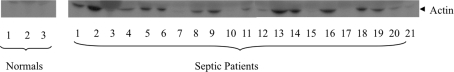
Actinemia occurs in human sepsis.Western Blot (WB) of plasma from septic patients and normals staining for actin shows that actin is present in the plasma of 17/21 patients, while Western Blot of three representative normals had no detectable actin in circulation.